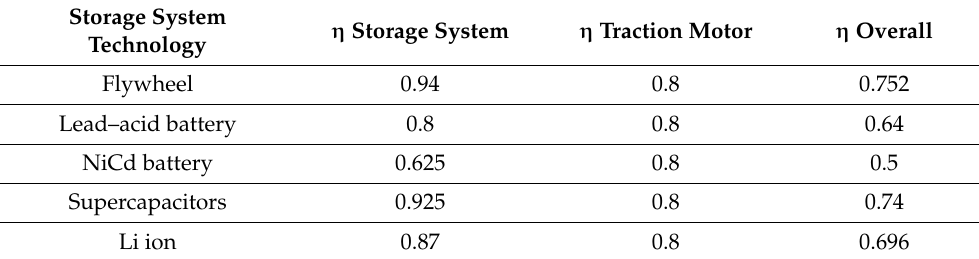
Table 2. The overall efficiency of the energy storage systems